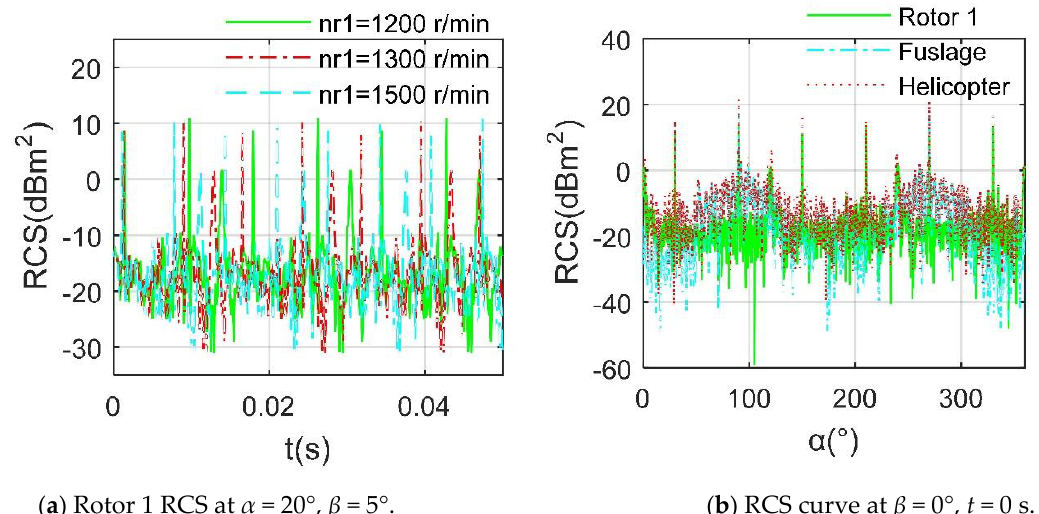
Figure 8. Electromagnetic scattering characteristics of rotor 1, f RH = 10 GHz.